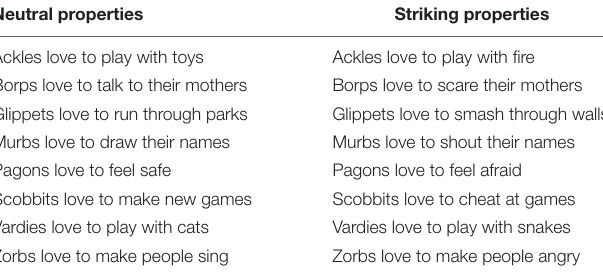
TABLE 1 | Items used in Experiments 1 and